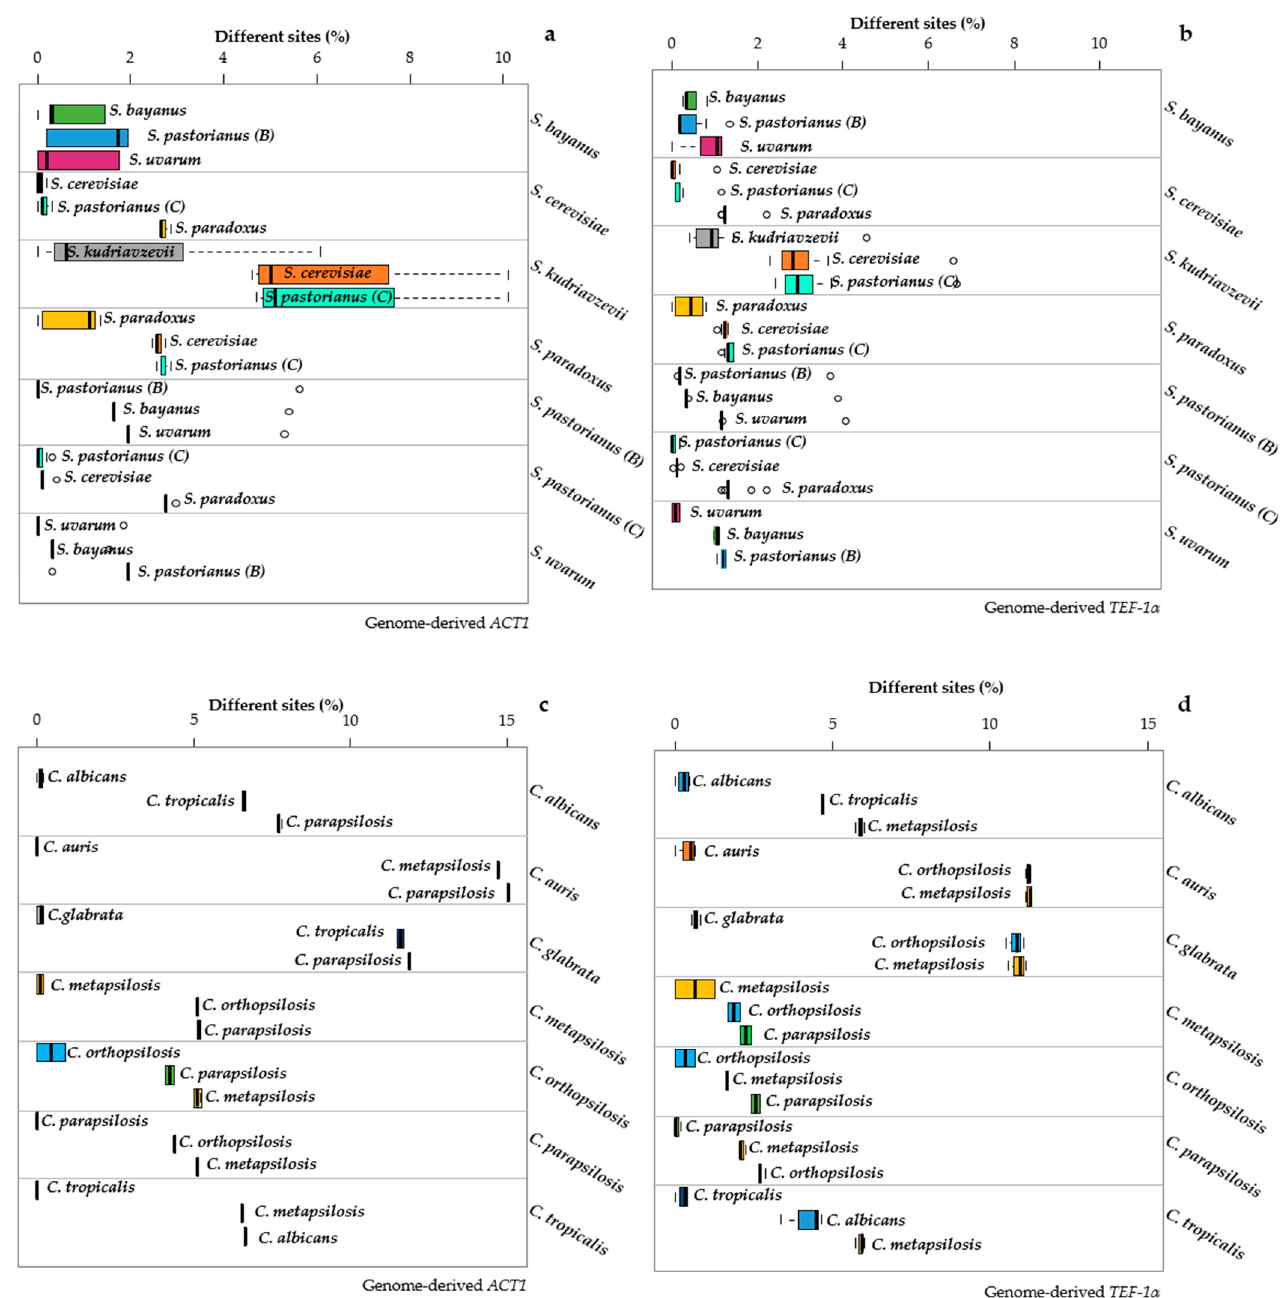
Figure 4. Distance among and within the Candida and Saccharomyces species. Distance calculated for the genomic Actin ( ACT1 ) and genomic Translational Elongation Factor 1-alpha ( TEF1- α ) of Saccharomyces are displayed in panels ( a , b ), respectively. Distance calculated for the genomic ACT1 and genomic TEF1- α of Candida are reported in panels ( c , d ). Each subpanel reports the distances of the strains belonging to the species under study (indicated on the right of the subpanel) with the sequences of the type strain of the three closest species (indicated close to the box). The width of each box represents the variability of the distances of the strains of each species from the type strains of the three closest species. The internal variability of each species is indicated by the topmost box of each subpanel. The distances among the means of the species are displayed as the distances between the vertical thick segments within the